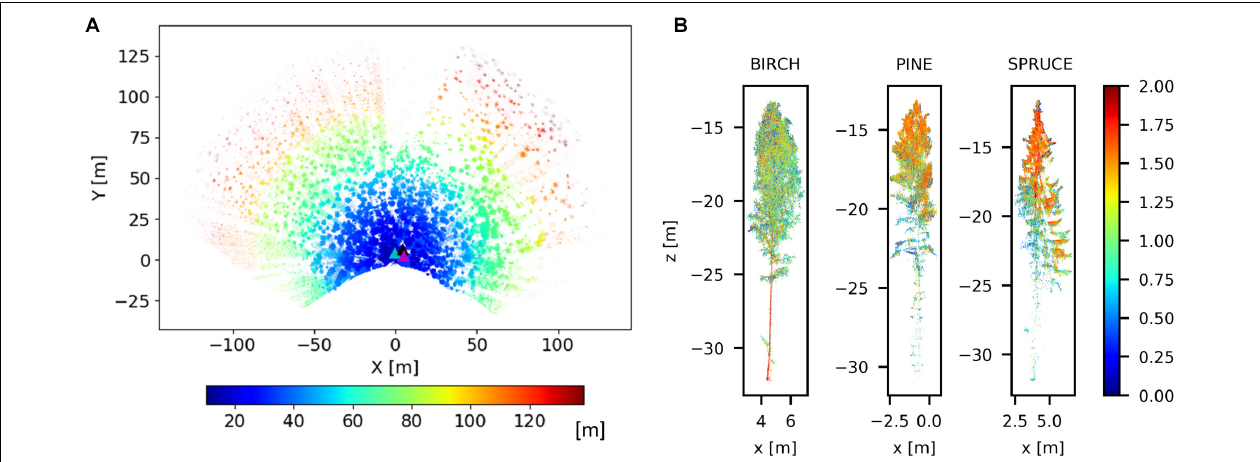
FIGURE 3 | Example of output point clouds from Hyytiälä test area acquired on 12 April 2020. (A) Top view of a filtered full point cloud colorized by range. The three example tree positions are highlighted with magenta (birch), black (Spruce), and cyan (Pine) triangles. (B) Individual tree points of a birch, a Scots pine and a Norway spruce colorized by point